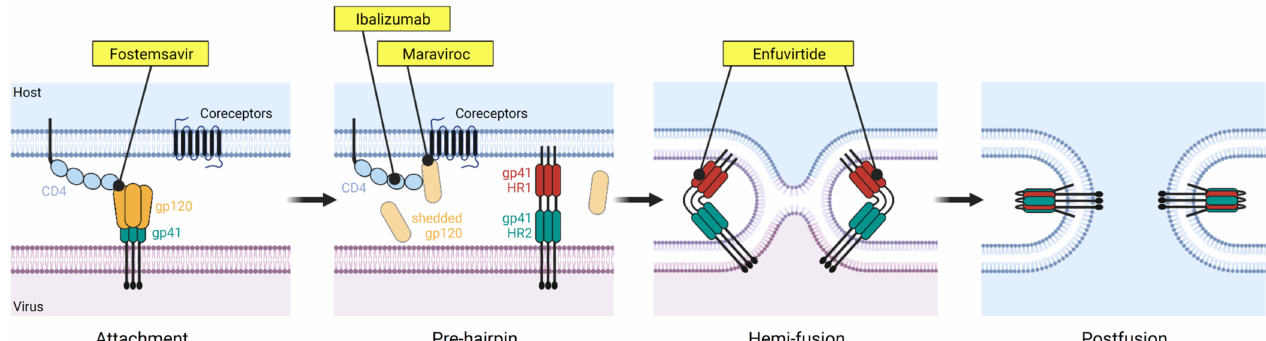
Figure 1. The HIV-1 entry process and FDA-approved drugs inhibiting this process. The HIV-1 entry is a complex process involving many steps. Four FDA-approved drugs targeting different steps of the HIV-1 entry are shown. These include fostemsavir that blocks CD4 binding (attachment inhibitor class), ibalizumab targeting the domain II of CD4 receptor (post-attachment inhibitor class), maraviroc binding to CCR5 coreceptor (CCR5 antagonist class), and enfuvirtide binding to gp41 (fusion inhibitor class). Figure was prepared in